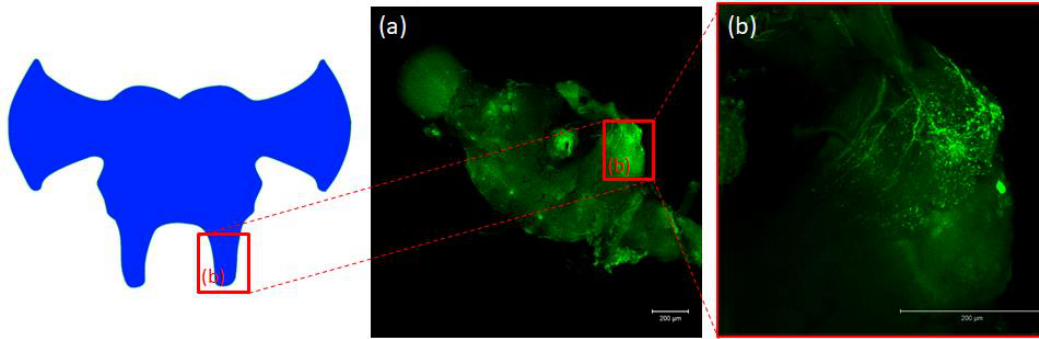
Figure 5. Schematic representation and images from confocal microscopy ( a ) of insect brain with immunofluorescent signals from anti-Manse-AST C in tritocerebrum ( b ), tritocerebrum with varicosities, fibers and somas containing Tenmo-PISCF. The selected scale is 200 μm.